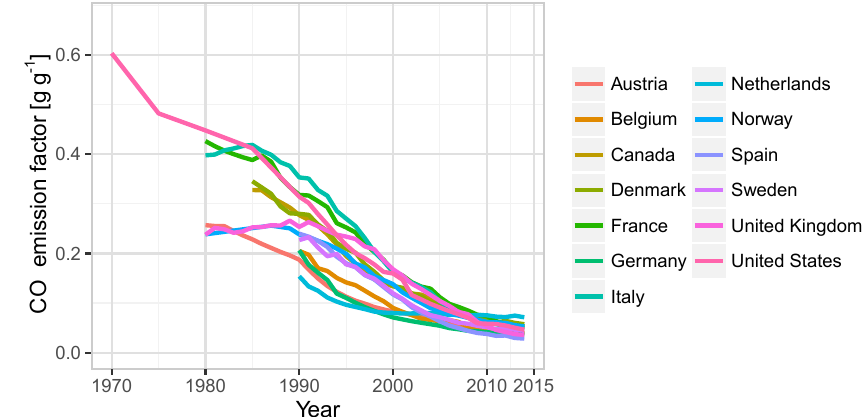
Figure 8. Implied CO emission factor for gasoline road vehicles obtained by the CEDS system after scaling to match country inventories. Data points are only shown where an inventory value was available in units of gCOg − 1 fuel. Table 7. Trends in observed and inventory NO X / CO emission ratios. City/country Years Observed ∗ MACCity ∗ CEDS (gridded –